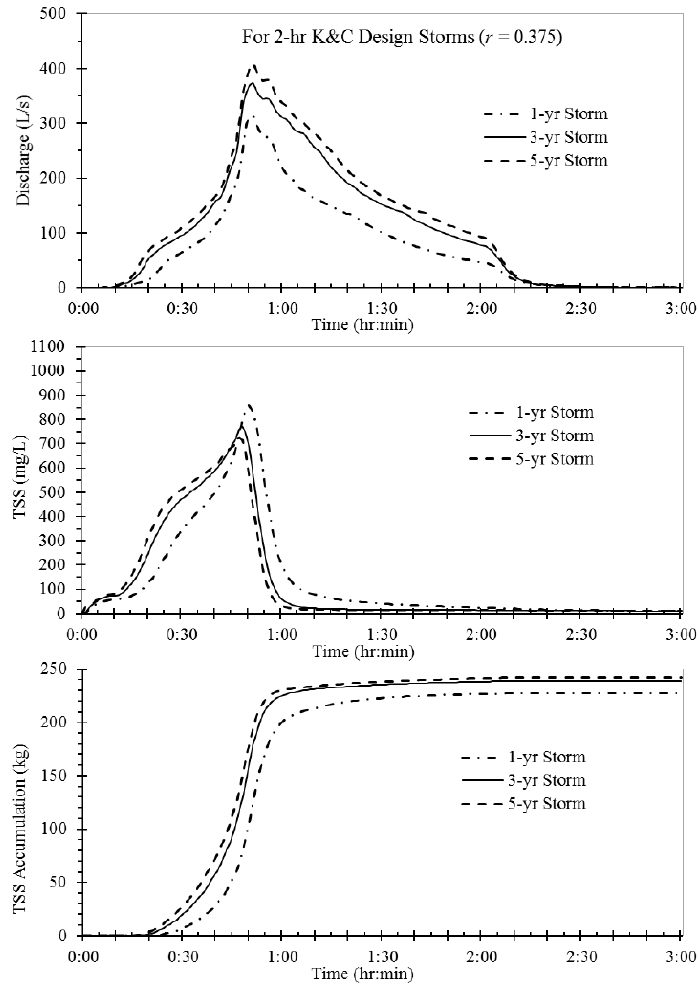
Figure 10. Simulated discharges (L/s), TSS concentration (mg/L), and accumulative TSS export (kg) at the catchment outlet for one ‐ , three ‐ and five ‐ year return periods of 2 ‐ h duration K&C design rainfall distributions.